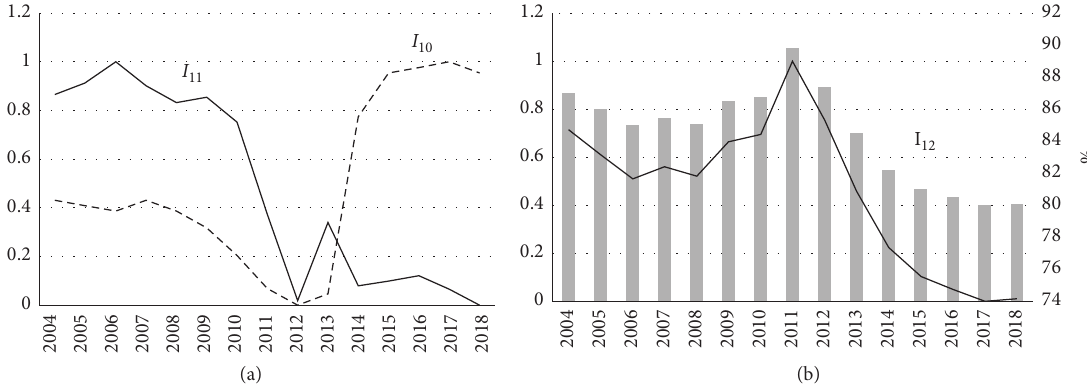
Figure 6: Dynamics of the factors of the level of loyalty to drug use: ( a ) indicators I and normalized